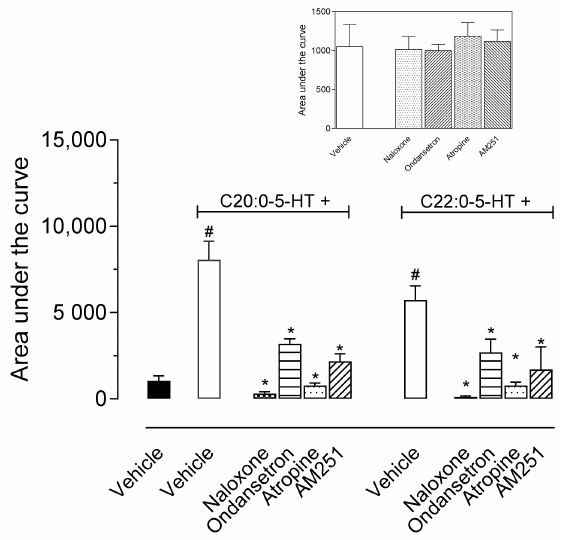
Figure 6. Effects of different antagonists on the antinociceptive activity of β N -arachinoyl-5- hydroxytryptamide (C 20:0 -5HT) and β N -behenoyl-5-hydroxytryptamide (C 22:0 -5HT) evaluated in the hot plate model. Naloxone (1 mg/kg, i.p.), ondansetron (0.5 mg/kg, i.p.), atropine (1 mg/kg, i.p.), or AM251 (1 mg/kg, i.p.), were administered 30 min prior to oral administration of C 20:0 -5HT or C 22:0 -5HT (10 mg/kg). All antagonists completely (naloxone and atropine) or partially (ondansetron and AM251) reverted the antinociceptive effect of C 20:0 -5HT and C 22:0 -5HT. Data are expressed as mean ± SD ( n = 8). One-way ANOVA followed by Tukey’s post hoc test was used to calculate the statistical significance. # p < 0.05, when comparing C 20:0 -5HT- or C 22:0 -5HT-treated mice to the vehicle-treated group and * p < 0.05, when comparing antagonists pretreated mice with C 20:0 -5HT or C 22:0 -5HT-treated groups.